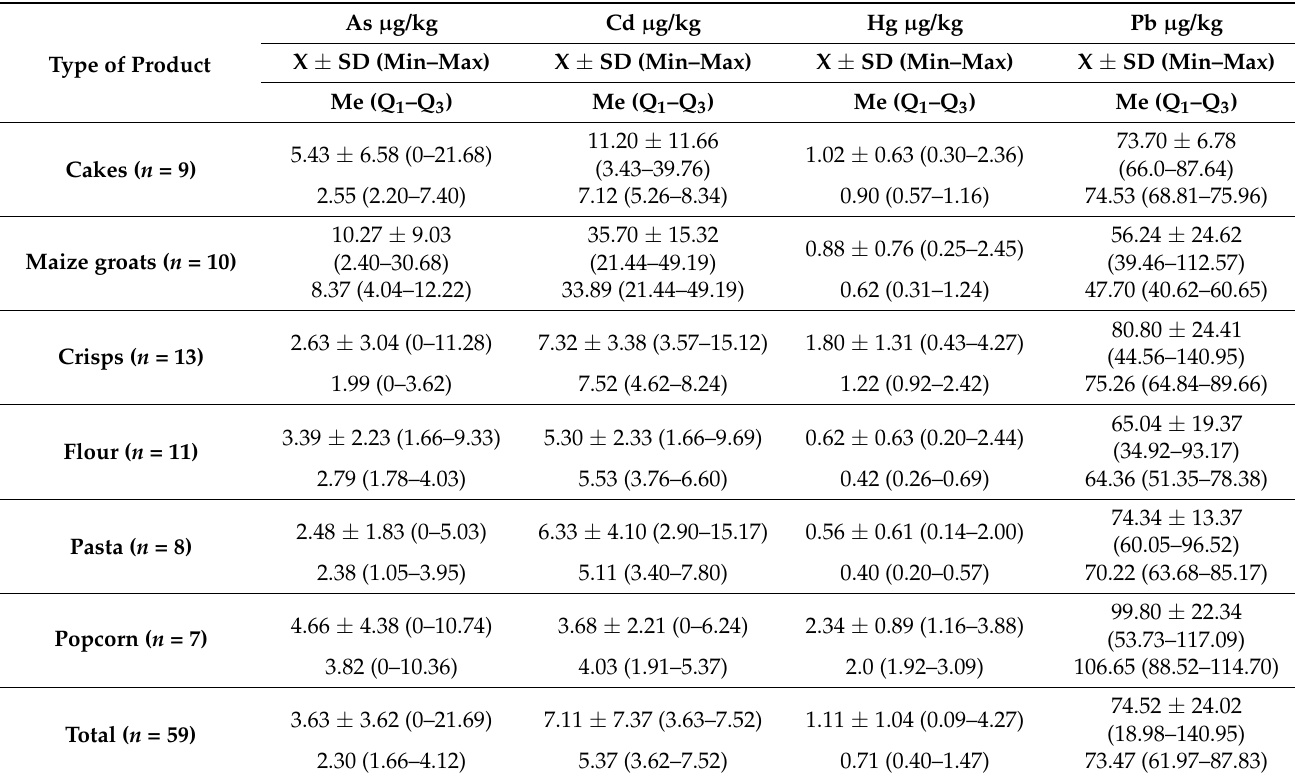
Table 2. The content of the toxic elements in maize